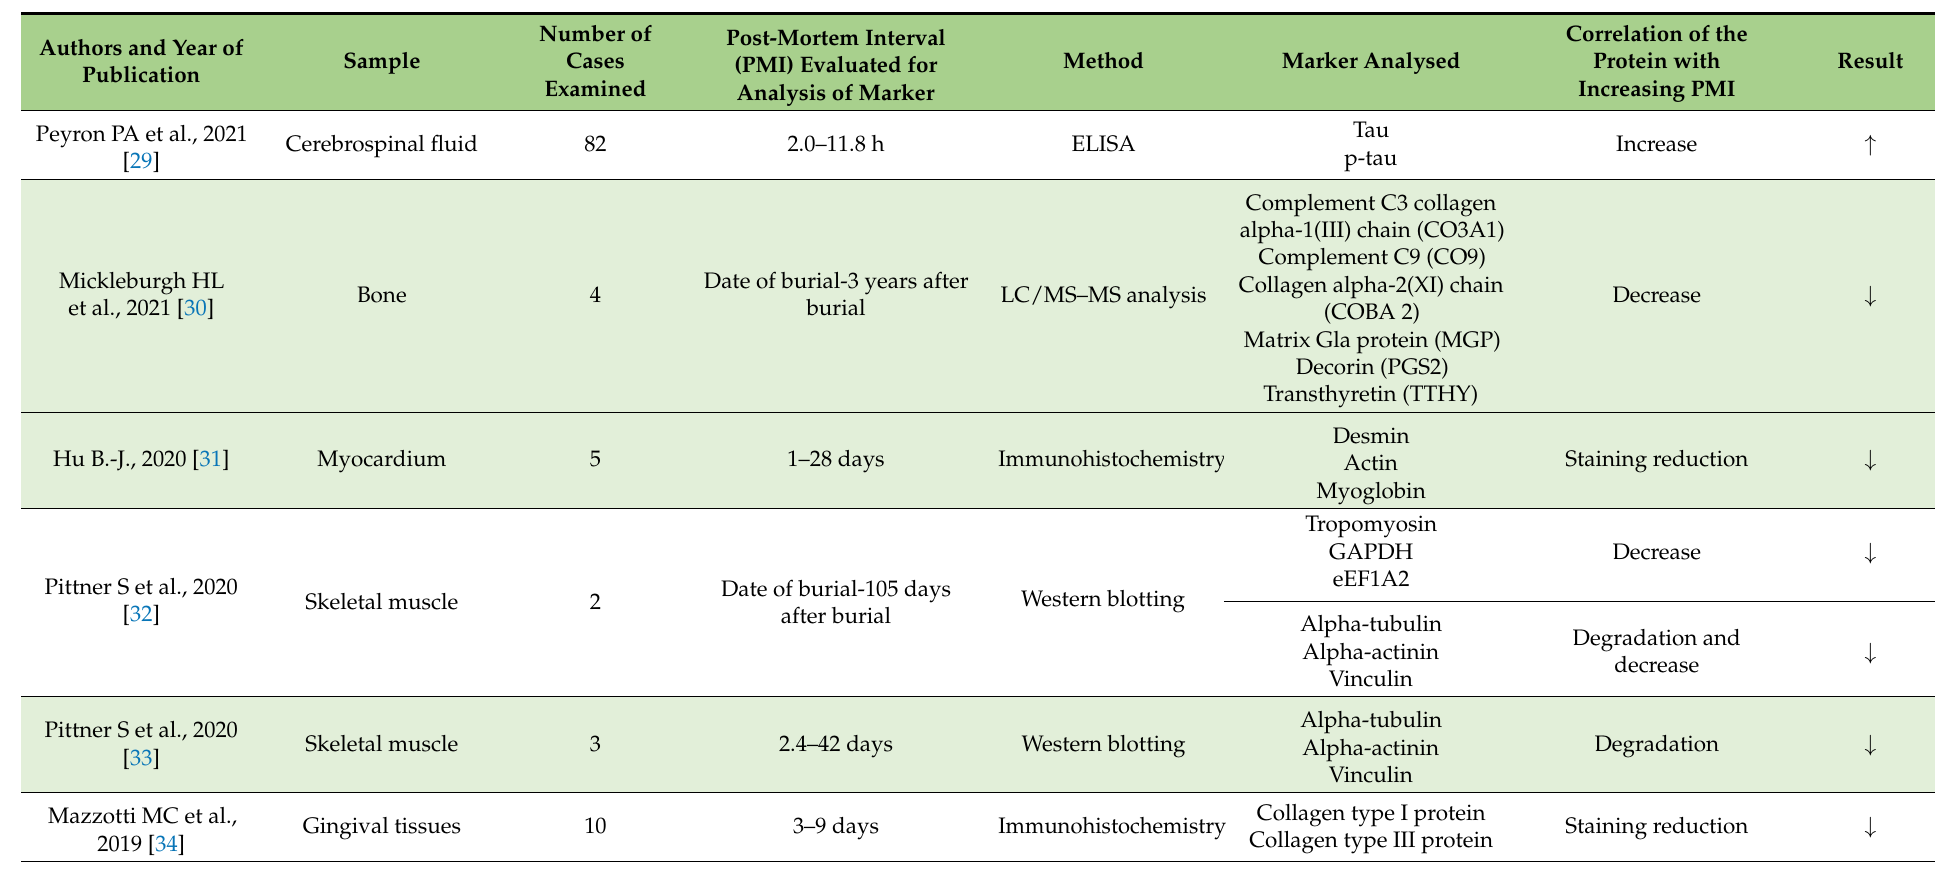
Table 2. Papers selected from the review on human models, with analysis of the sample examined, number of cases, PMI investigated, method used, marker investigated and related results. ↑ increase; ↓ decrease/degradation; - no